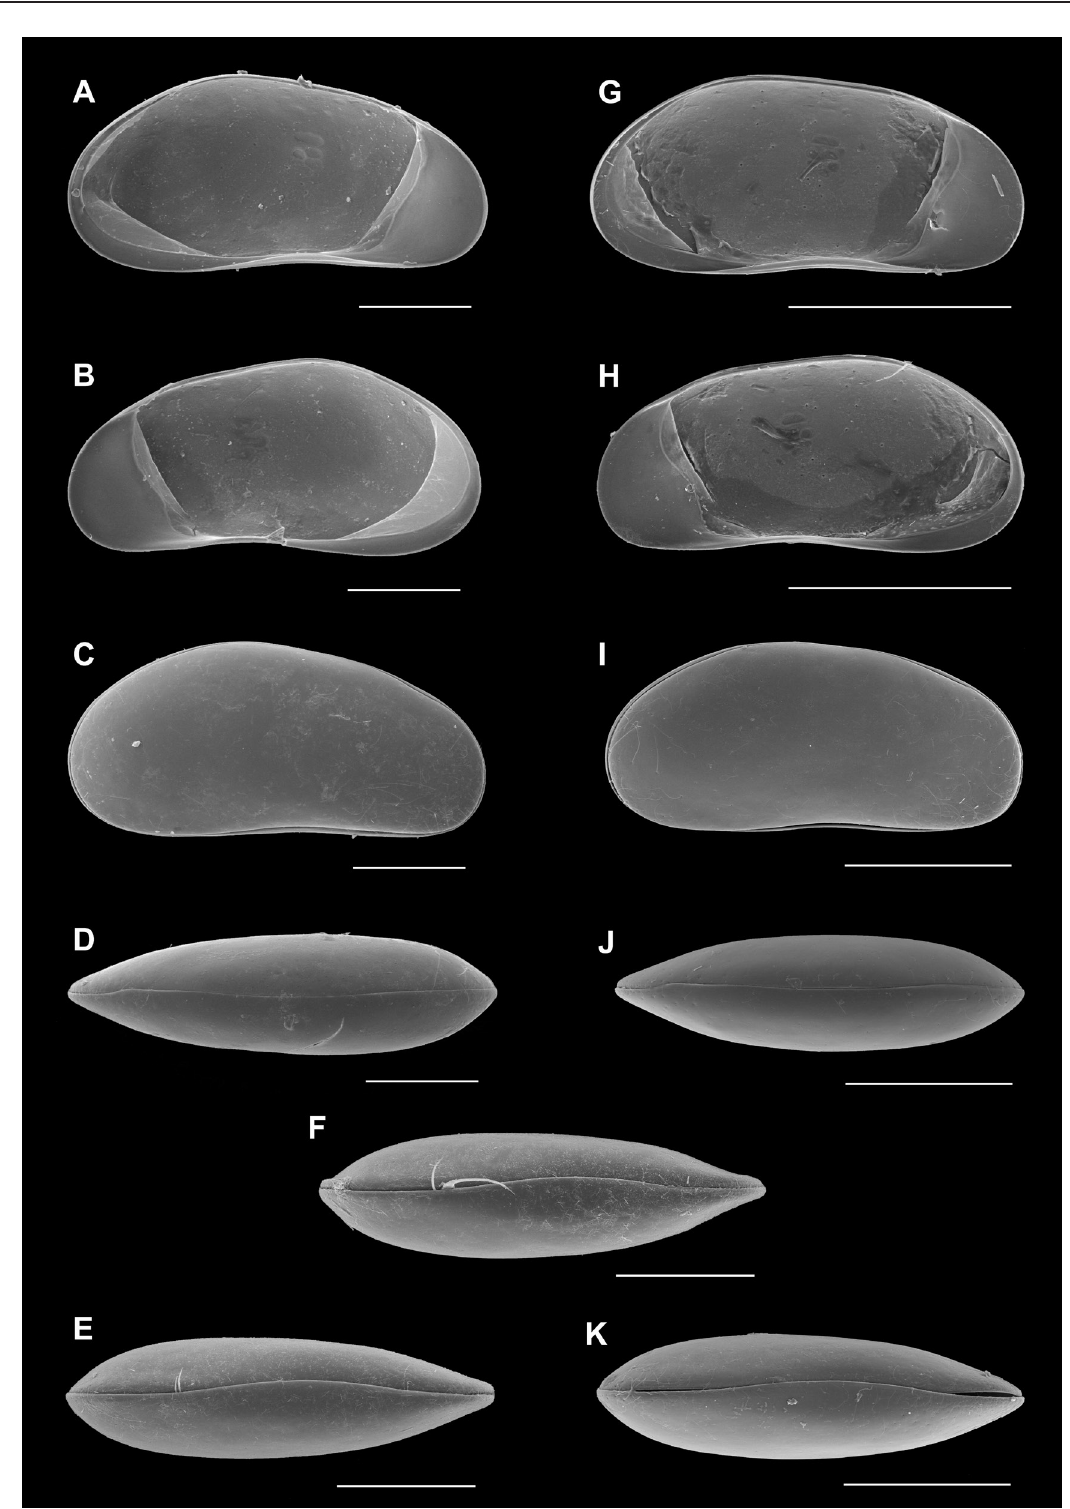
Fig. 2. Candobrasilopsis rochai gen. nov. sp. nov., valves (A-F ♂ and G-K ♀). A, G . LV, internal view (A: MZUSP.28113, G: MZUSP.28103). B, H . RV, internal view (B: MZUSP.28113, H: MZUSP.28103). C, I . Cp, right lateral view (C: OC.3291, I: OC.3293). D, J . Cp, dorsal view (D: MZUSP.28106, J: MZUSP.28112). E, F, K . Cp, ventral view (E: MZUSP.28108, F: MZUSP.28107, K: OC.3294). Scale bars: A-D = 200 µm; E, F = 250 µm; G, H = 400 µm, I-K = 300